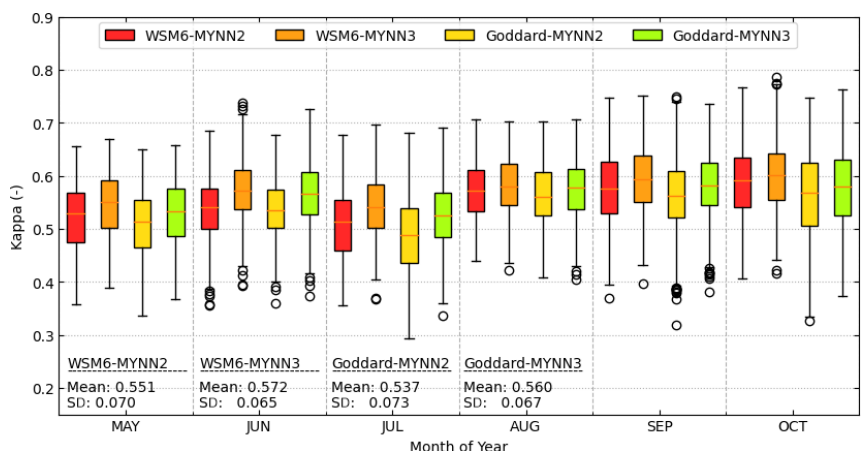
Figure 18. The monthly box plot of the four cases by the κ for the 6 months simulation from June to October. The yearly means and standard deviations of the κ are shown for four cases at the bottom of the